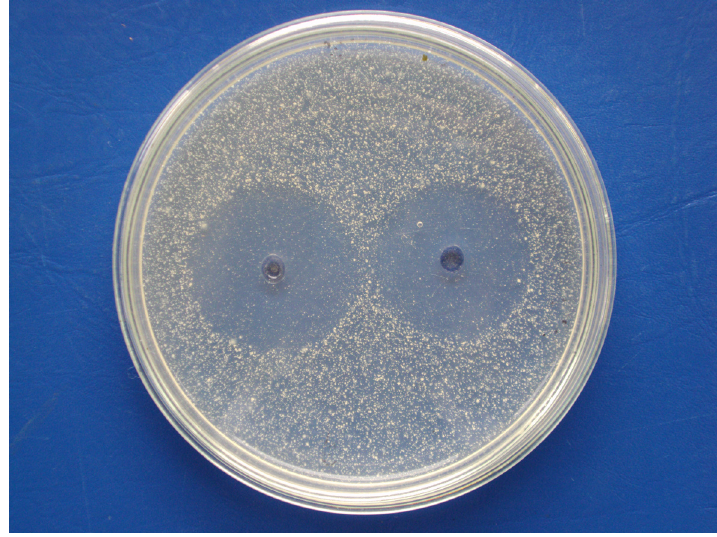
Fig. 1. Inhibition zones produced by methanol extracts